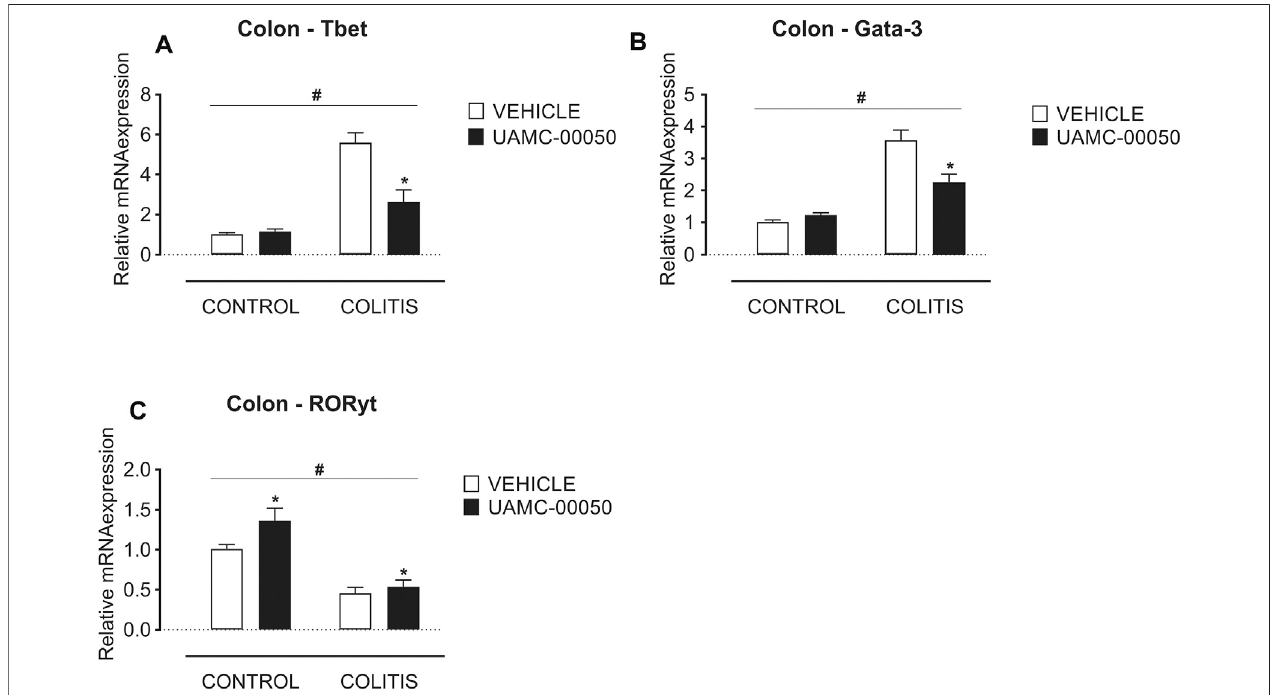
FIGURE 4 | Effect of curative treatment with UAMC-00050 on colonic mRNA expression of Tbet, Gata-3 and ROR γ t. Effect on expression of Tbet (A) , Gata-3 (B) and ROR γ t (C) ,determined post-mortem at week4(aftera2-week treatment withUAMC-00050). Dataarerepresented asmean ± SEM.Two-way ANOVA followed by One-way ANOVA and LSD post-hoc test when appropriate. # p < 0.05; signi fi cant effect of colitis, * p < 0.05; signi fi cant effect of treatment, n (cid:2) 7 – 8/group.